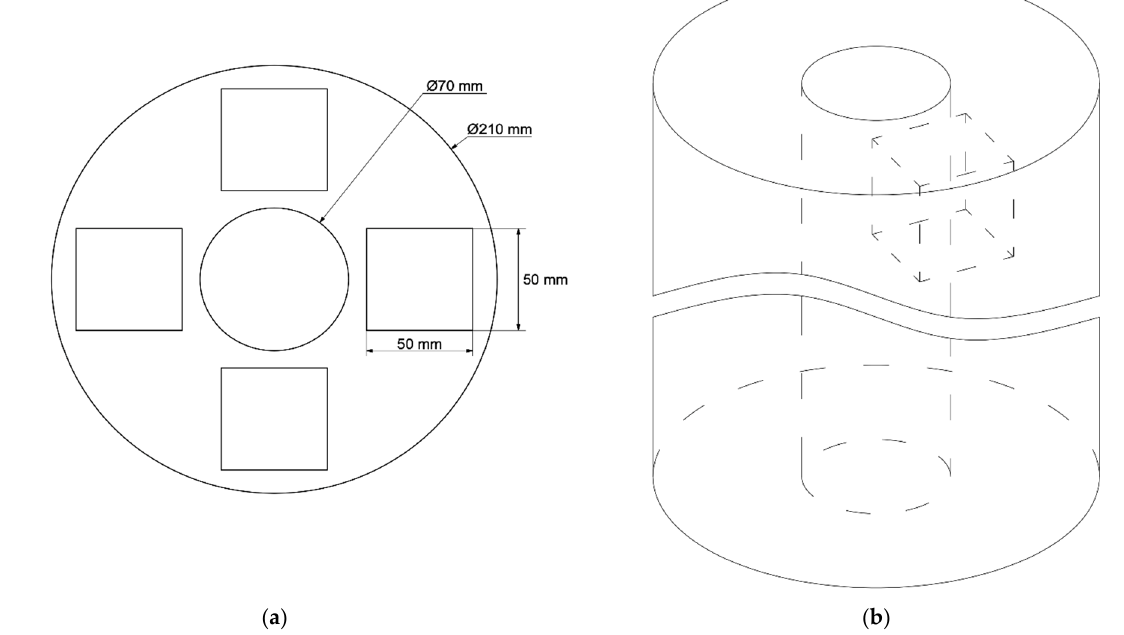
Figure 1. Scheme of sawing centrifuged and vibrocentrifuged samples: ( a ) top view; ( b ) general view. The plan of experimental studies of vibrated, centrifuged, and vibrocentrifuged con- crete samples is shown in Figure 2.